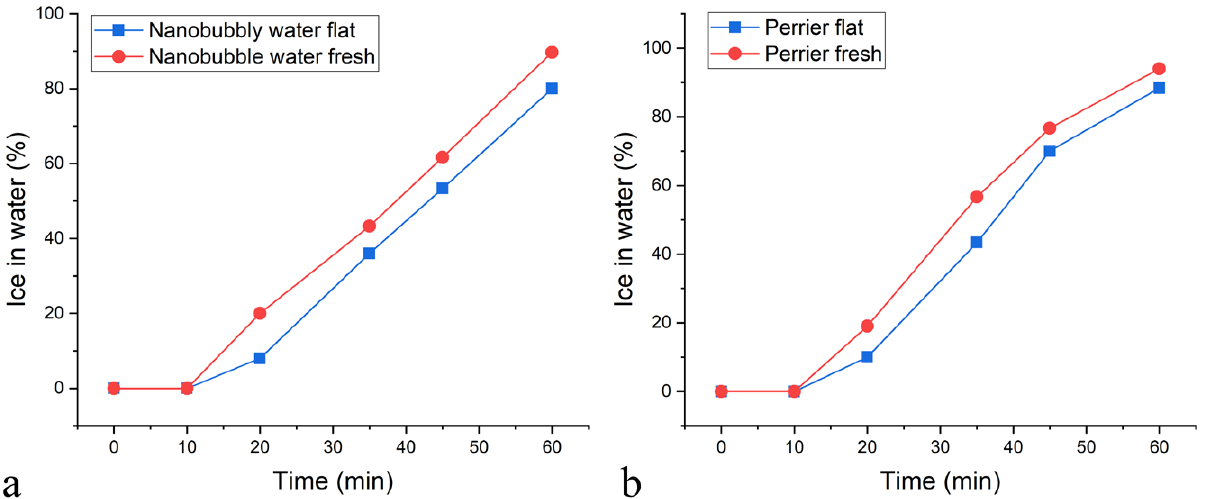
Figure 6. Percentage of the total volume of ice in the 30 ml water samples as a function of the time of incubation at -18 o C for the starting water temperature of 21.3 o C and for fresh and flat nanobubbles-containing water (a) and fresh and flat Perrier as a commercial carbonated mineral water